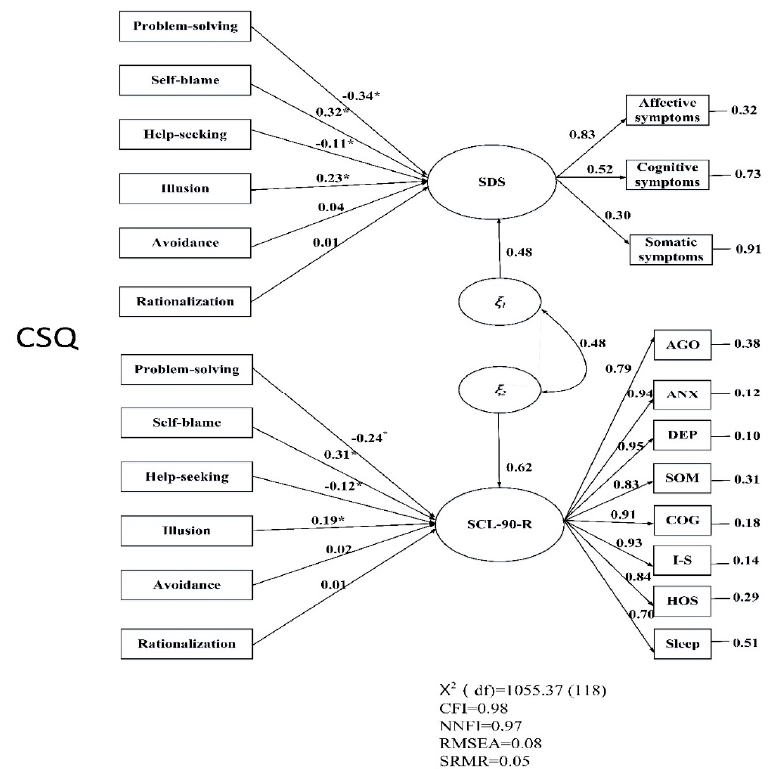
Figure 1. SEM of Coping Style Questionnaire (CSQ), Self-Rating Depression Scale (SDS), and Symptom Checklist 90-Revised (SCL-90-R). The six coping styles of CSQ were as exogenous variables by summing the scores of the corresponding items. The factor structure of SDS used Kitamura et al.’s [15] three-factor model and SCL-90-R used Arrindell and Ettema’s [21] eight-factor model. Note. * p < 0.05.